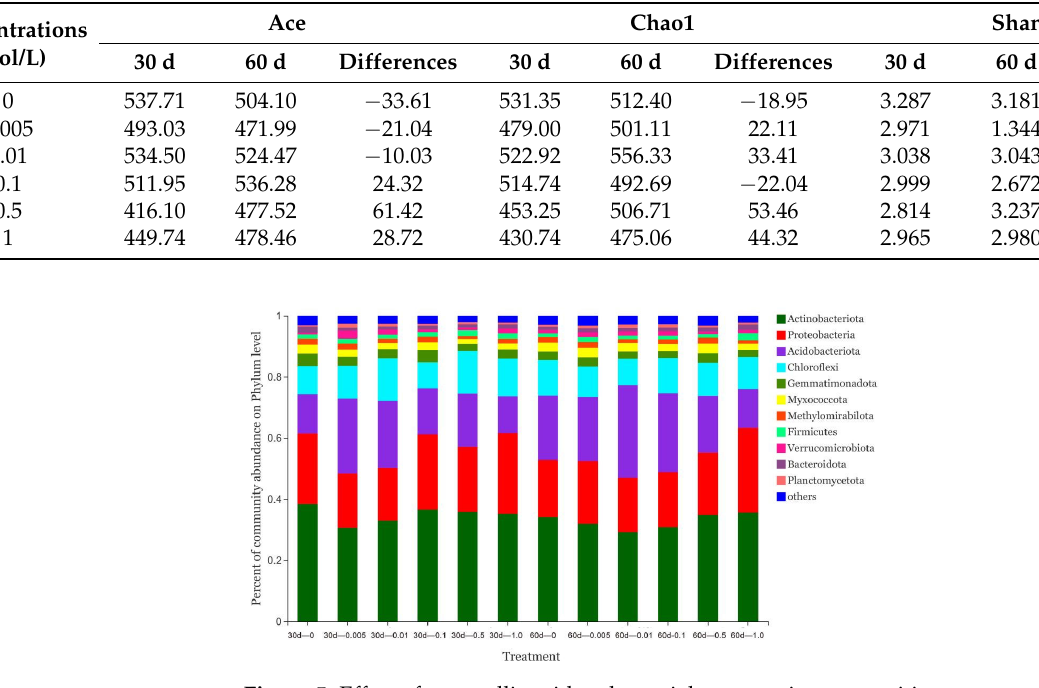
Table 5. Effect of pyrogallic acid on fungal diversity.